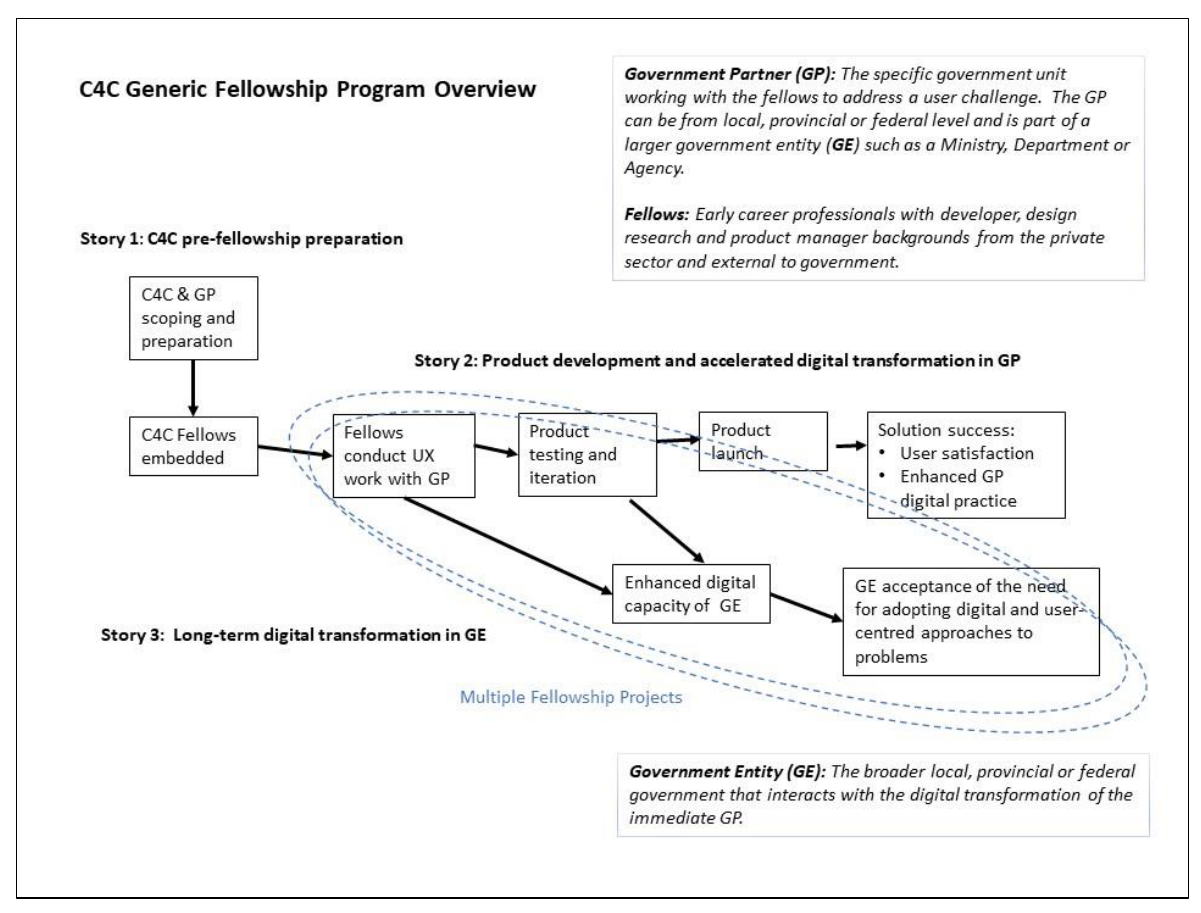
Figure 3: Code for Canada Fellowship Theory of Change